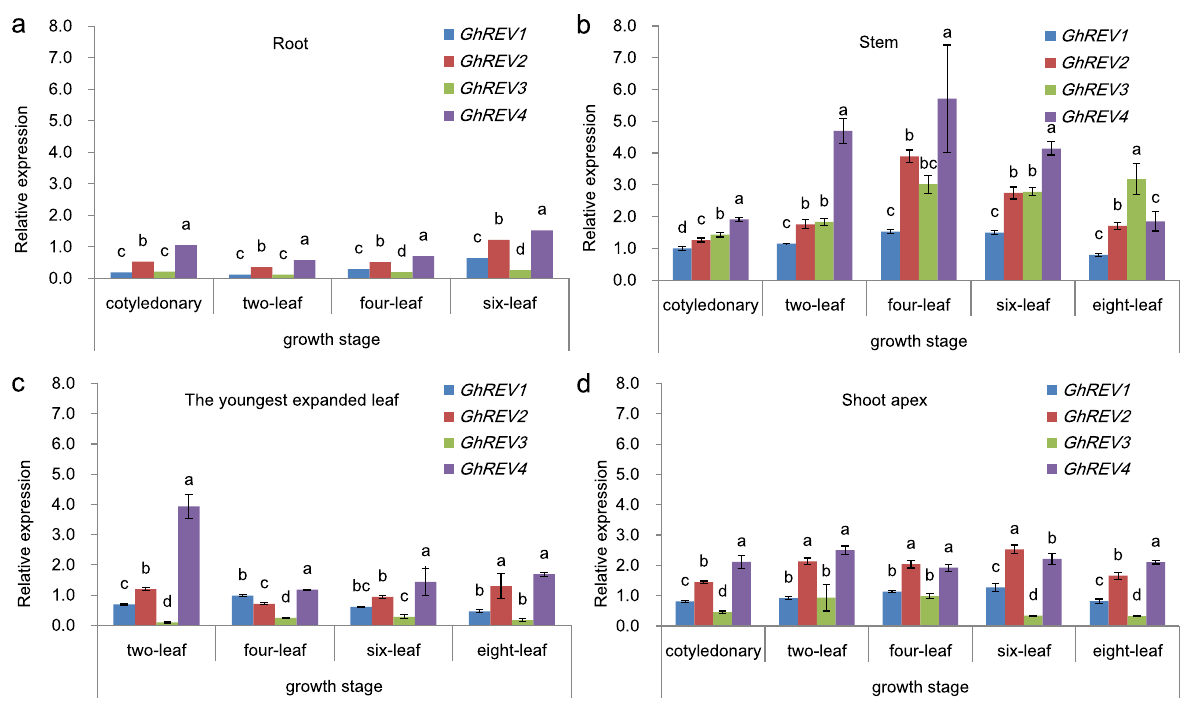
(Fig. 2d), there were no obvious and explicit differences from the cotyledon stage to the 6 th or 8 th leaf stage.